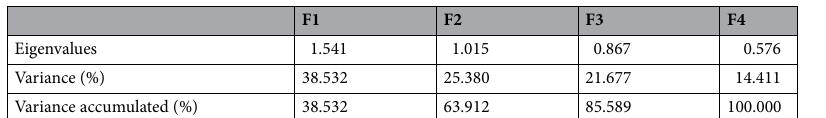
F1 F2 F3 F4 Table 1. Principal components (PC), eigenvalues, percentage of the variance for each component and the total variance of brain lipids in HFD-fed and Chow-fed mice from LC–MS–MS data.